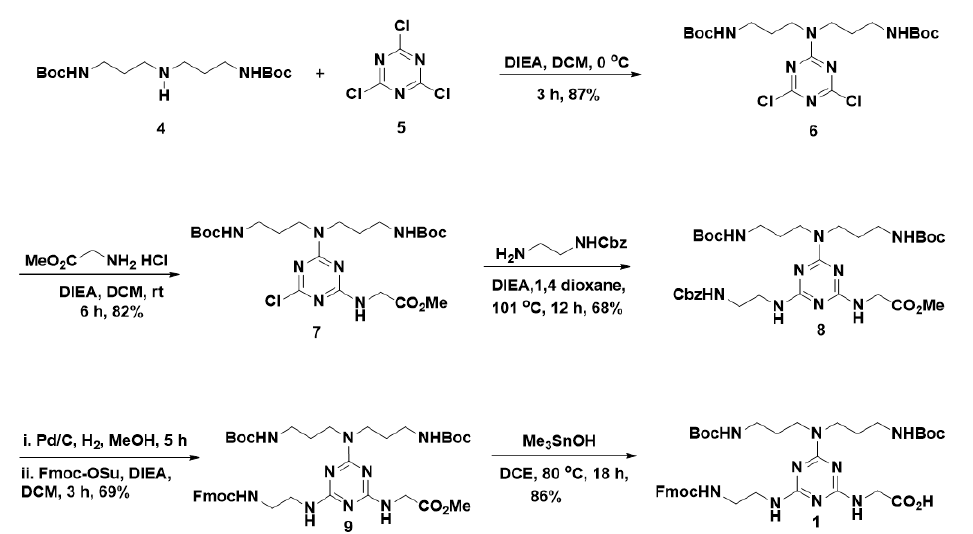
Scheme 1: Synthesis of cationic Fmoc-triazine amino acid . Scheme 1. Synthesis of cationic Fmoc-triazine amino